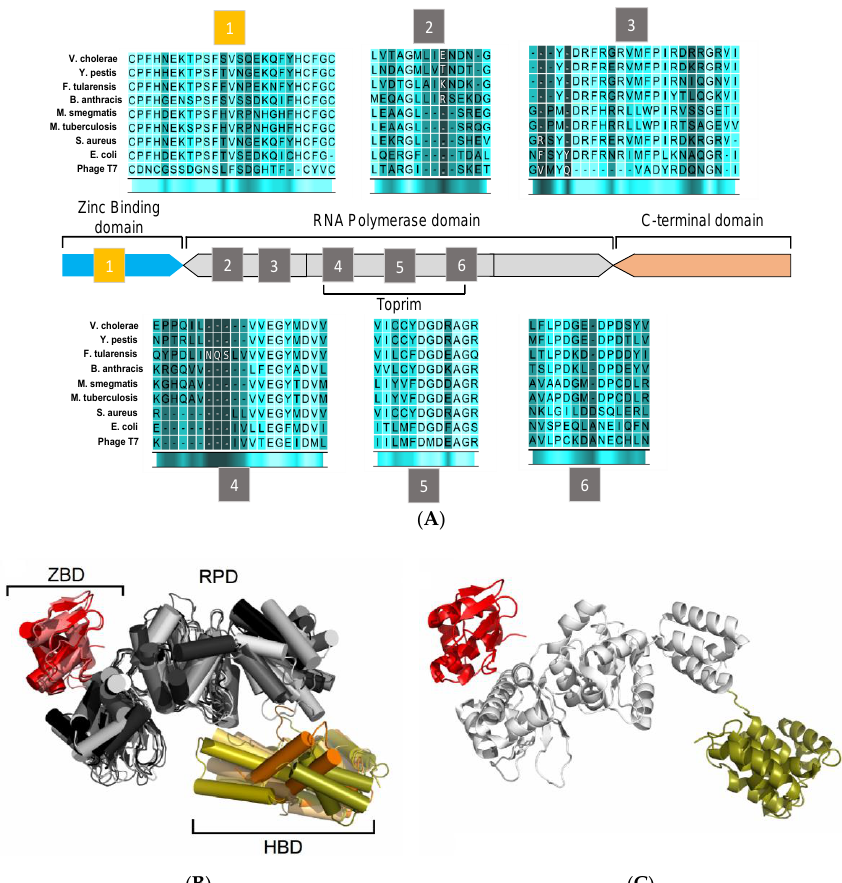
Figure 2. Sequence and structural homology of DnaG-like primases. ( A ) Domain organization and arrangement of motif sequences of prokaryotic DNA primases. ( B ) Structural alignment of DnaG primase domains: zinc-binding domain (ZBD) of A. aeolicus (PDB ID 2AU3), and B. stearothermophilus (PDB ID 1D0Q). RNA polymerase domain (RPD) of A. aeolicus (PDB ID 2AU3), B. subtilis (PDB ID 5GUJ), E. coli (PDB ID 1DD9), M. tuberculosis (PDB ID 5W33), Pseudomonas aeruginosa (PDB ID 5VAZ), and S. aureus (PDB ID 4E2K). C-terminal domain of B. stearothermophilus (PDB ID 1Z8S), E. coli (PDB ID 2HAJ), H. pylori (PDB ID 4EHS), S. aureus (PDB ID 2LZN), and V. cholerae (PDB ID